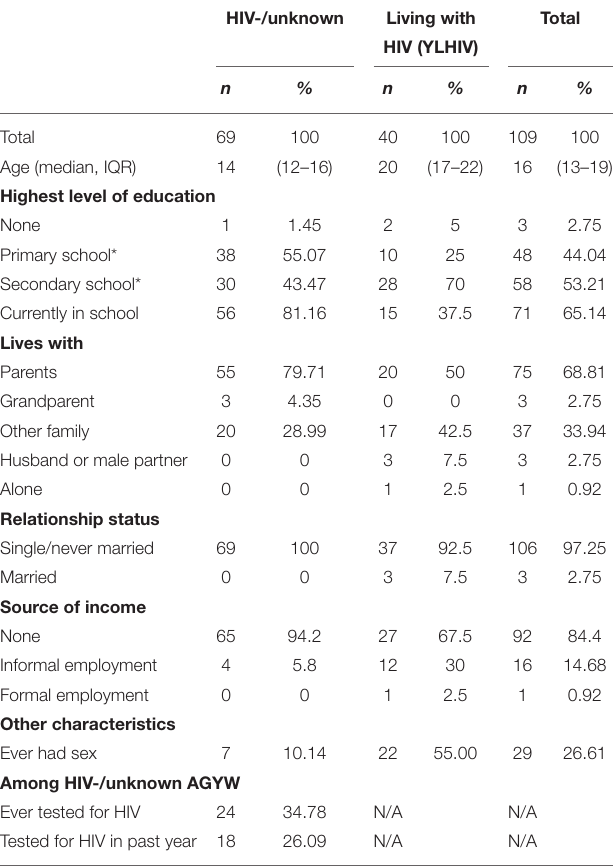
TABLE 2 | Characteristics of study participants.